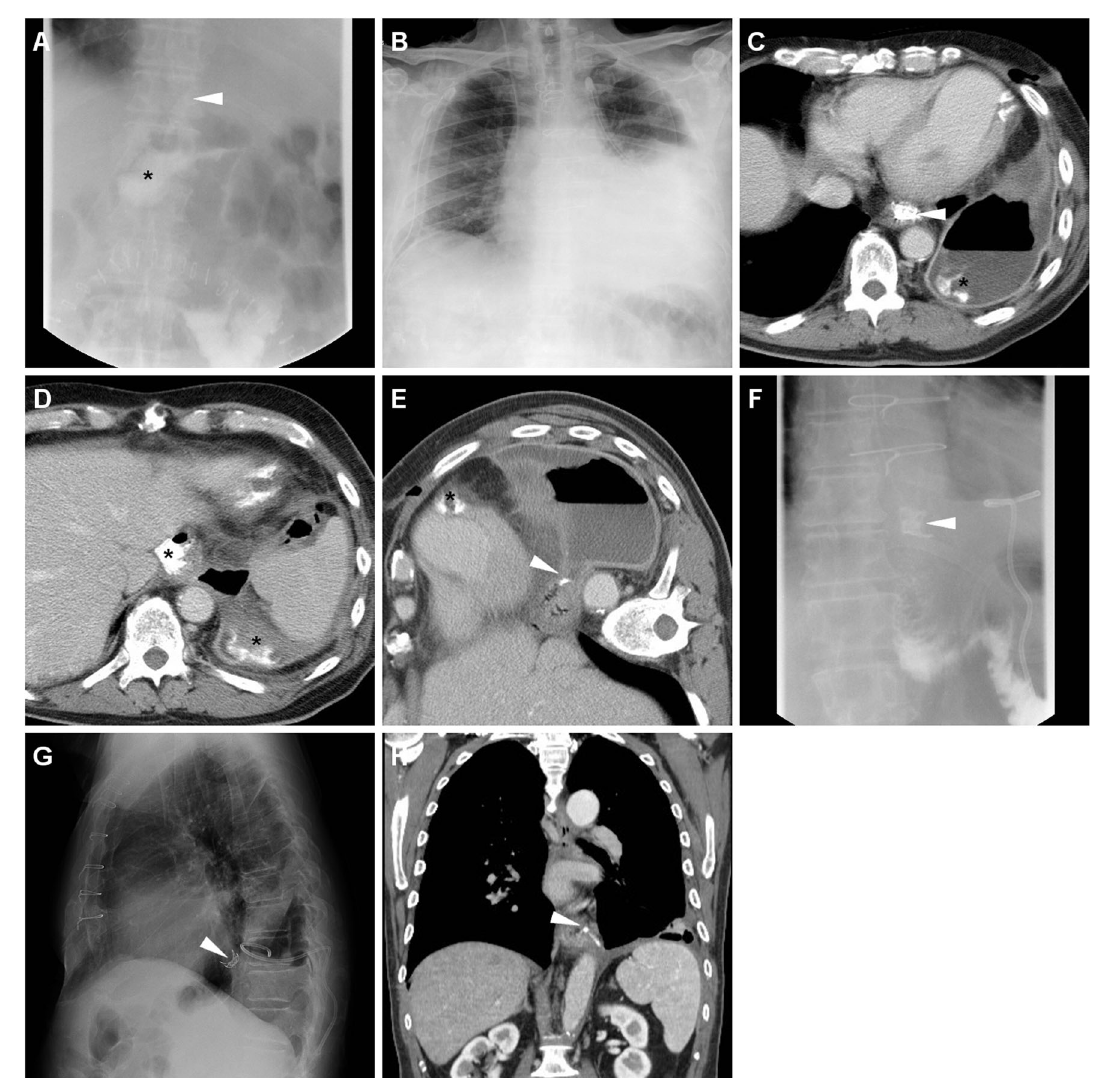
contrast leakage (*) was seen both medially to the EJS (arrowheads) and dependent in the left pleural empyema. Repeated CT obtained in the right lateral decubitus position (E) before CT-guided pleural drainage confirmed anastomotic fistula from the EJS (arrowhead) to the hydropneumothorax, which was treated by endoscopic clipping (arrowhead in F); note pleural pigtail